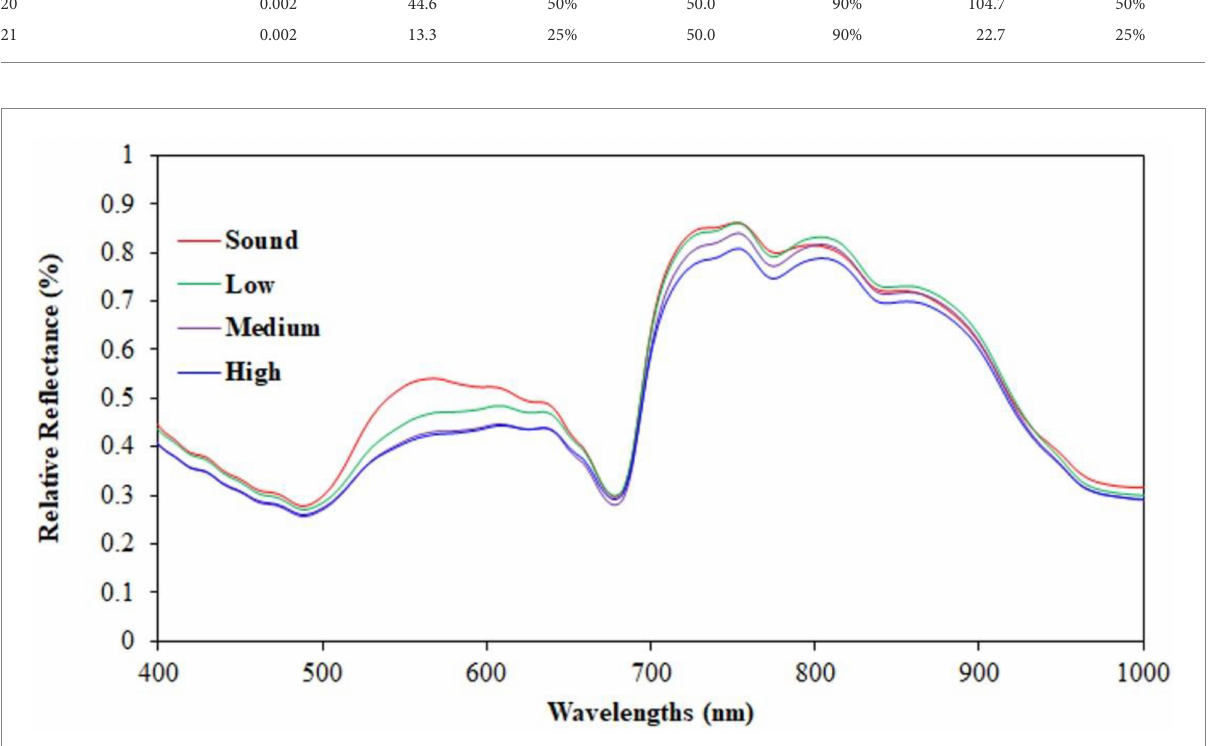
FIGURE 4 Averaged relative reflectance of sound apple regions and of bruised regions caused at low-, medium-, and high-impact energy